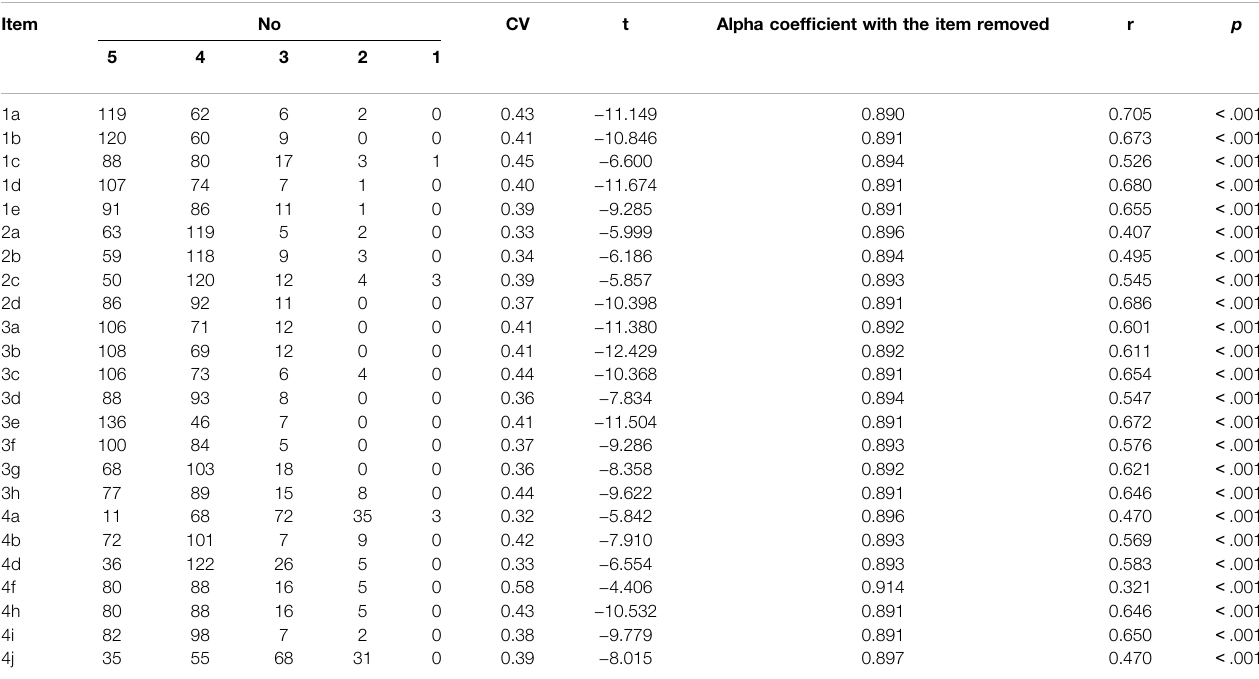
TABLE 3 | Item screening of the Chinese version of